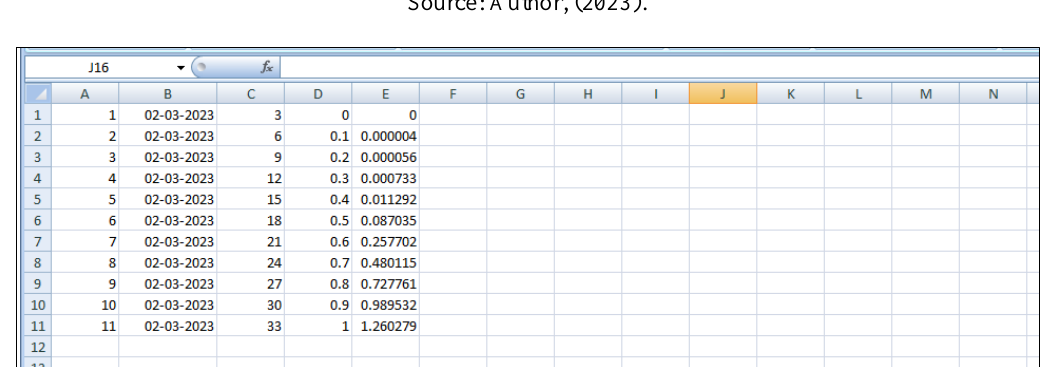
Figure 2: Block diagram of the programme Main_Prog_GUI.vi that revokes other two sub-programme files from ' For Loop 1 ' and ' For Loop 2 '.